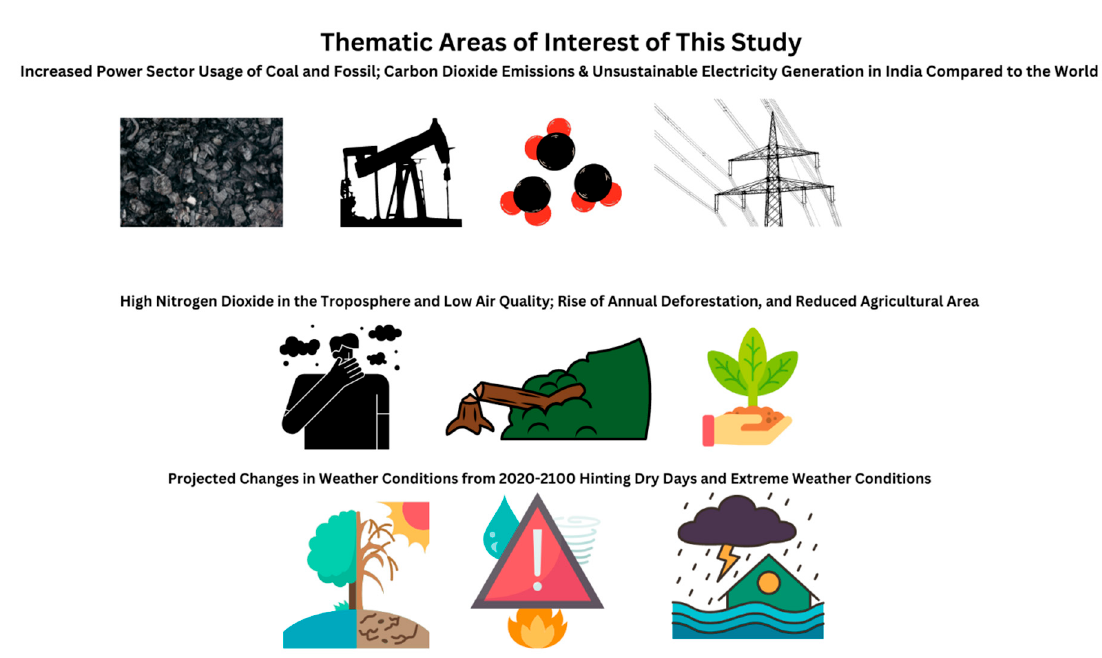
Figure 12. Thematic areas of interest of this study.